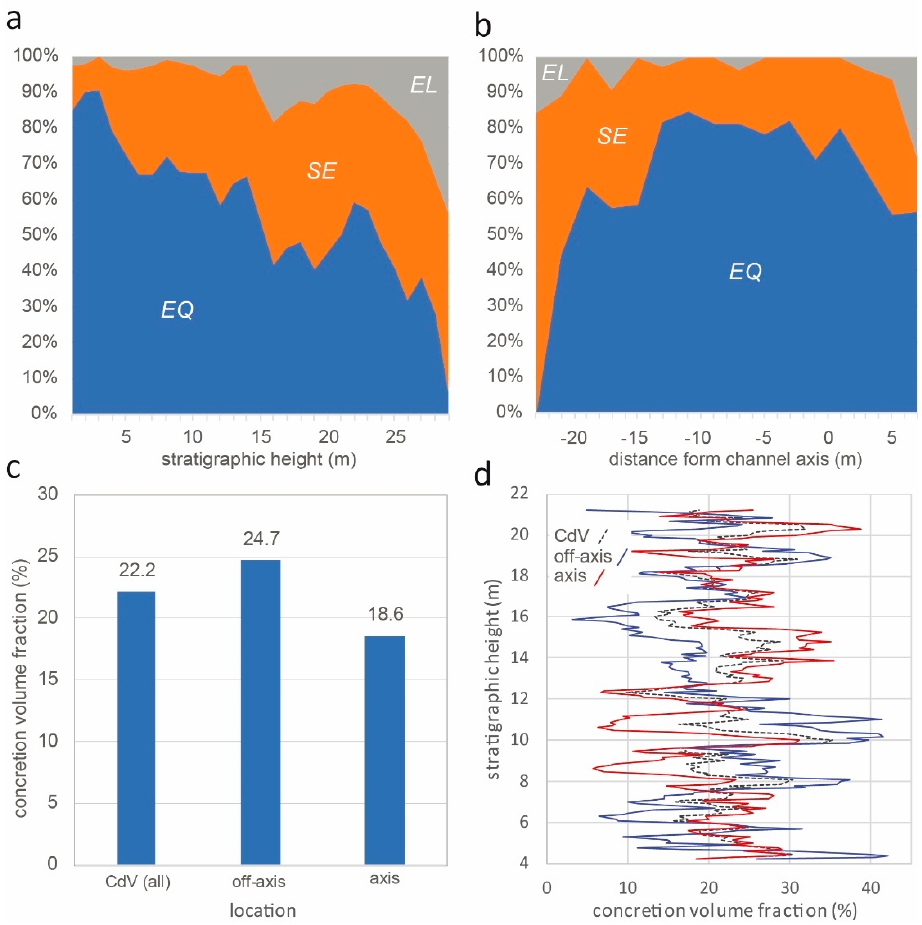
Figure 9. ( a ) Variability of abundance of equant (EQ), sub ‐ equant (SE) and elongated concretions with respect to stratigraphic height ( a ) and distance from channel axis ( b ); ( c ) Bar chart showing cumulative volume fraction of concretions in the whole studied outcrop, and off ‐ axis and channel ‐ axis locations; ( d ) Vertical proportion curves of concretion showing the stratigraphic variability of concretion volume fraction.